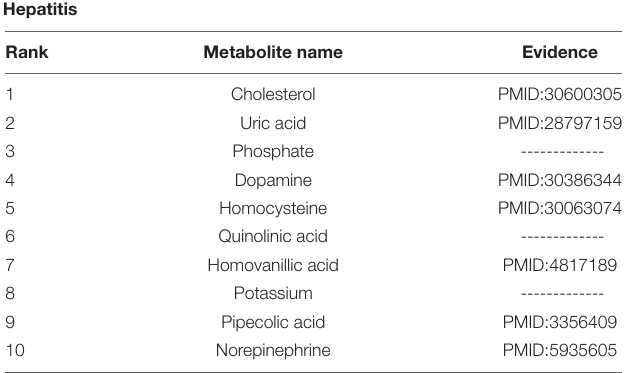
TABLE 1 | Candidate metabolites of hepatitis.